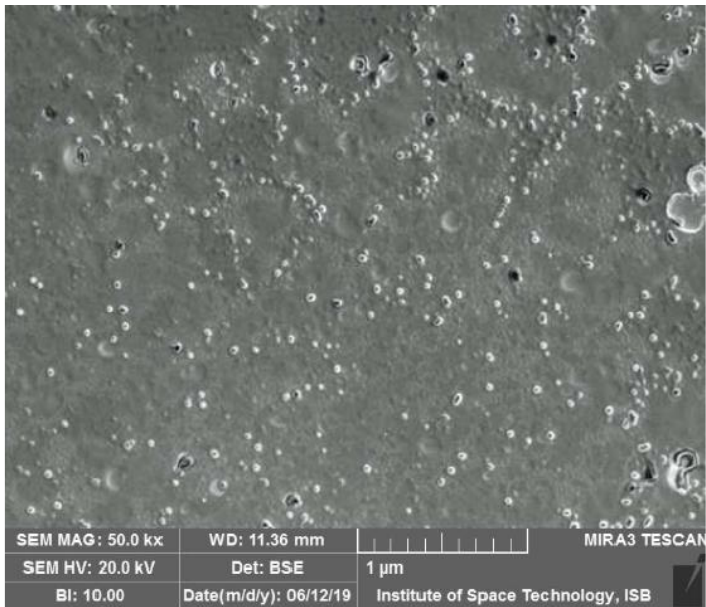
Figure 7. SEM image of optimized nanoformulation.